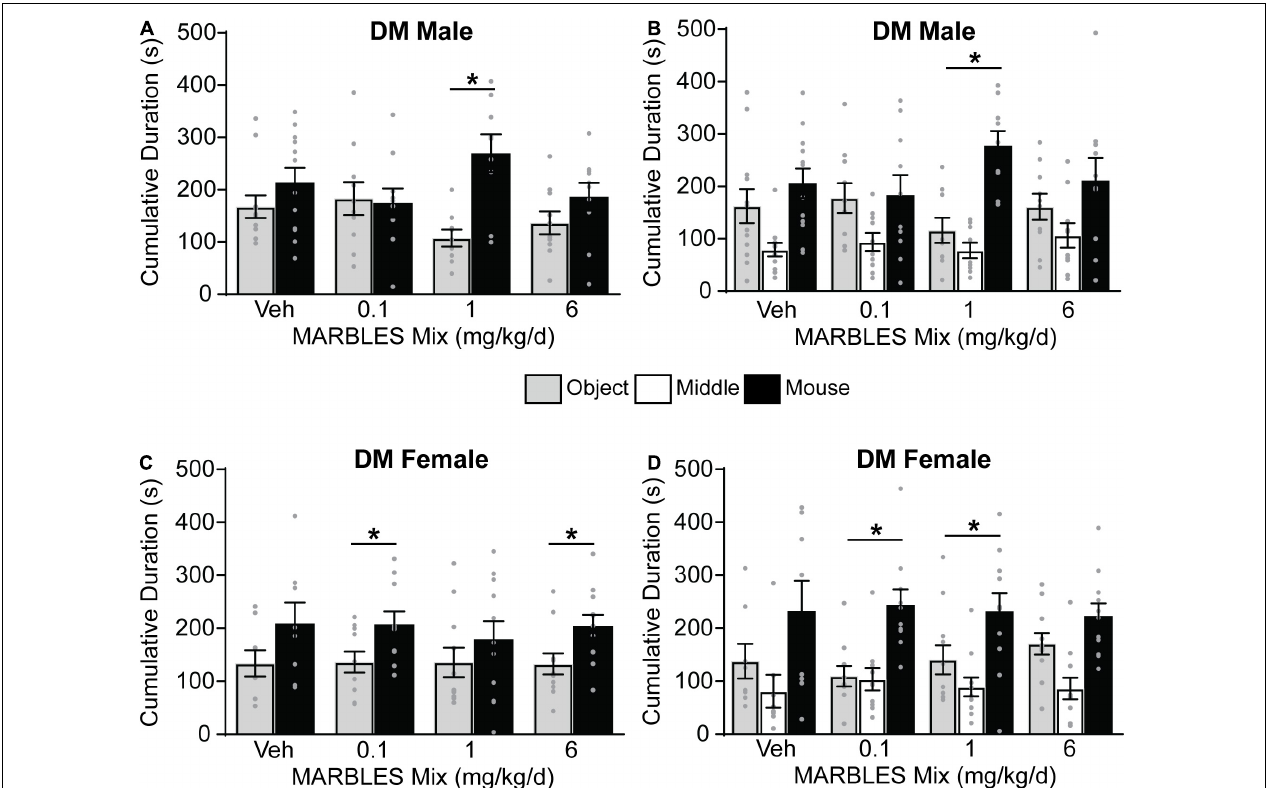
FIGURE 6 | Sociability in male and female DM mice was altered by genotype and PCB exposure. (A,C) The amount of time males (A) or females (C) mouse spent sniffing either a novel sex- and age-matched mouse or a novel object. (B,D) The amount time males (B) or females (D) spent in each chamber side. Data presented as mean ± SEM ( n = 8–12). * Indicates significant difference between novel mouse vs. novel object at p < 0.05 as determined using an unpaired t -test, Mann-Whitney test or unpaired t -test with Welch’s